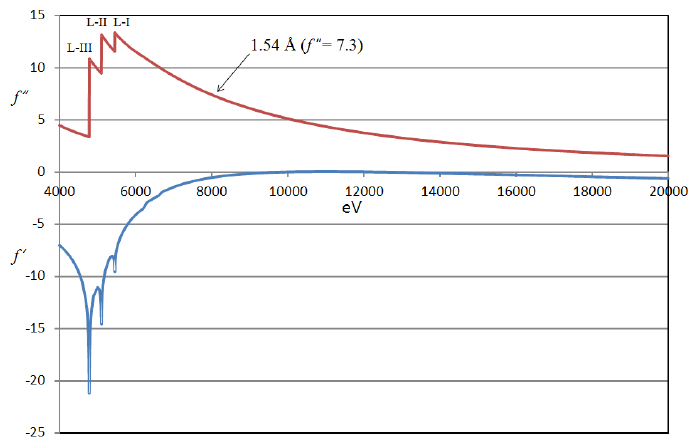
Figure 1. Xe scattering factors as a function of X-ray energy. The f’ and f” scattering factors as a function of energy are plotted for Xe near the L-absorption edge. A wavelength of 1.54 Å was used for the single wavelength anomalous diffraction (SAD) experiment during the de novo phasing. The anomalous scattering coefficients f’ and f” as a function of incident X-ray energy was taken from the following: http://skuld.bmsc.washington.edu/scatter/AS_periodic.html.